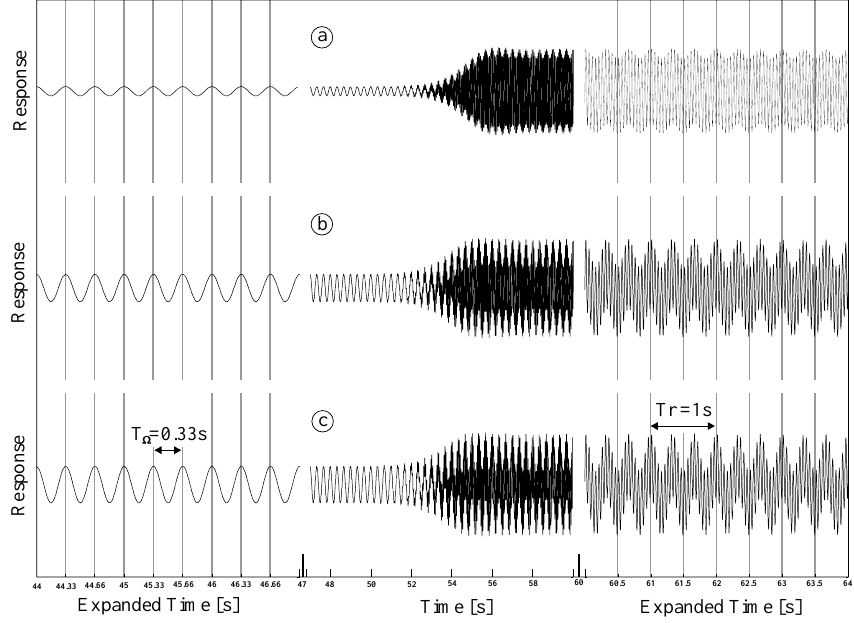
Fig. 17. Predicted system’s dynamic behavior when Ω : ¯ ω n = 3:20: (a) H 6 = 0.47; (b) H 6 = 1.43 and; (c) H 6 =